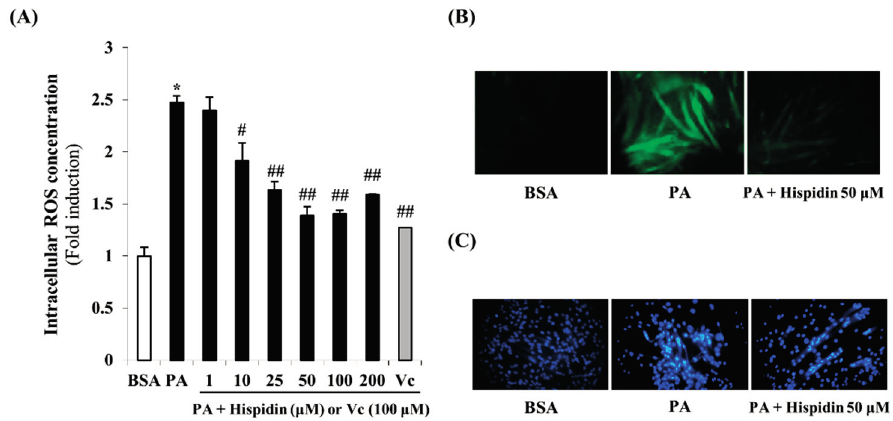
Figure 3. Protective effect of hispidin on palmitate-induced oxidative stress in C2C12 myotubes. ( A ) Intracellular ROS scavenging activity of hispidin on palmitate-treated C2C12 myotubes. Cells were treated with 1 to 200 μ M hispidin or 100 μ M Vitamin C (Vc) for 8 h, and then 1 mM palmitate was added for 16 h. The intracellular ROS generation was measured by DCF-DA methods. Data represent the mean ± standard error of three independent experiments. * p < 0.05, as compared with only BSA group, # p < 0.05, as compared with PA group, ## p < 0.05, as compared with PA group. ( B ) Fluorescence microscopic images of cells stained for ROS (magnification 400×). ( C ) DNA condensation of C2C12 myotubes was detected by Hoechst 33342 staining. DNA condensation in